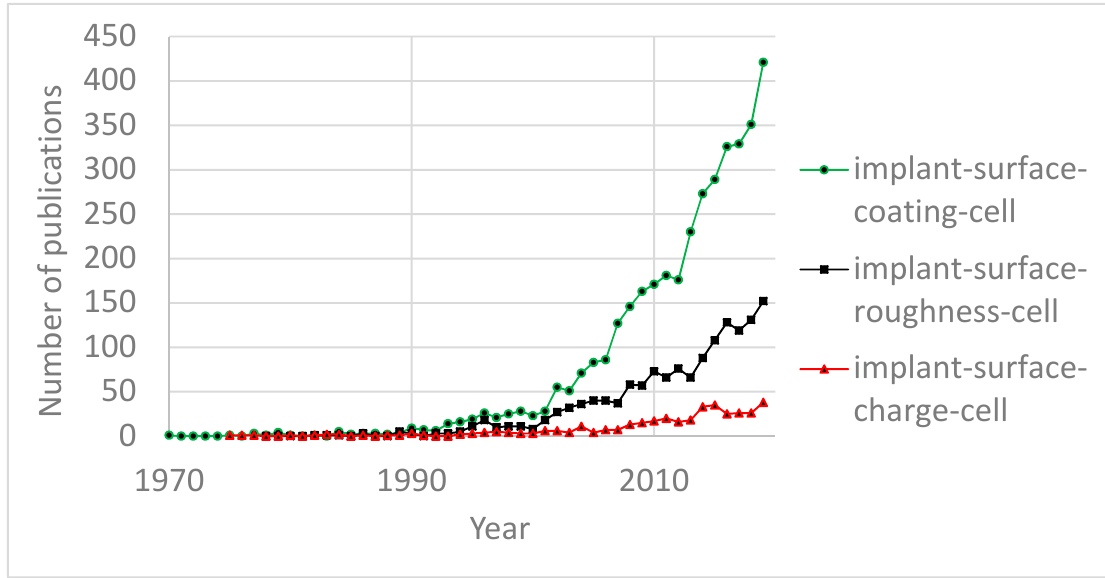
Figure 1. Annual number of publications.